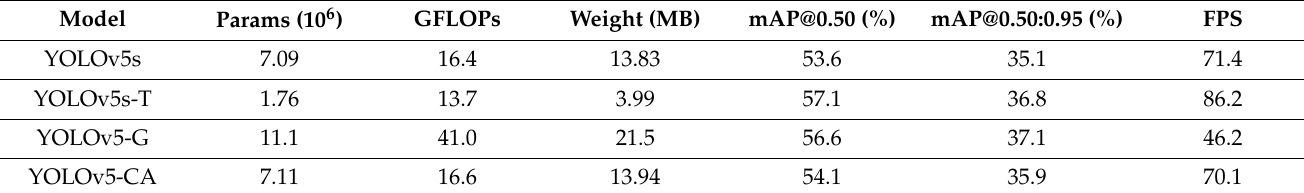
Table 2. Complexity and performance comparison of object detection